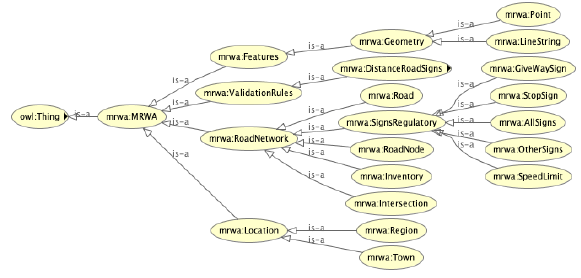
Figure 3. Representation of the MRWA